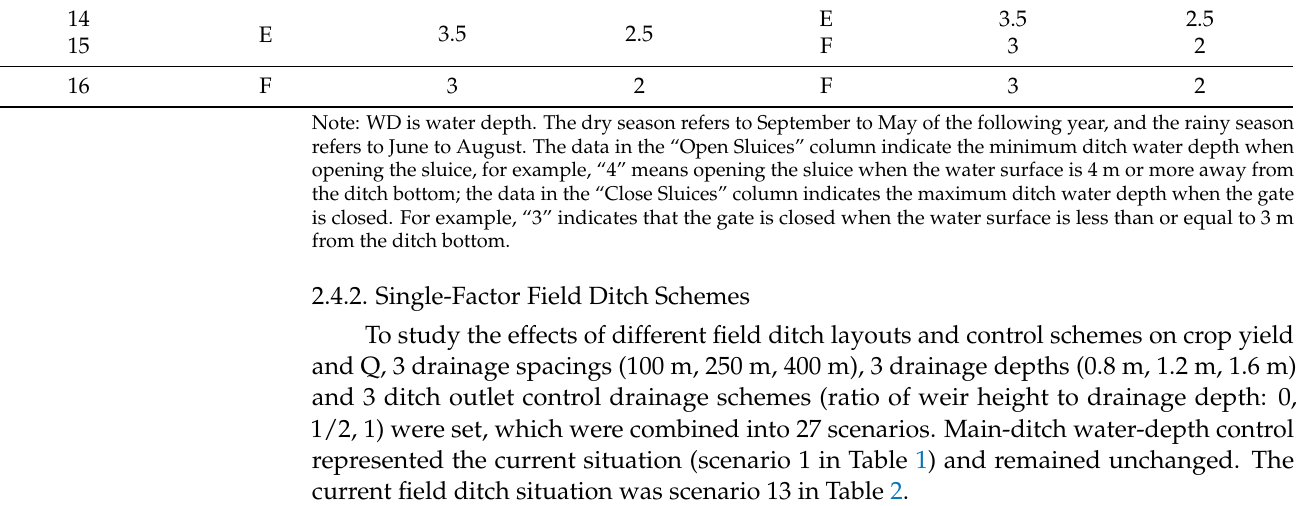
Table 2. Single-factor field ditch